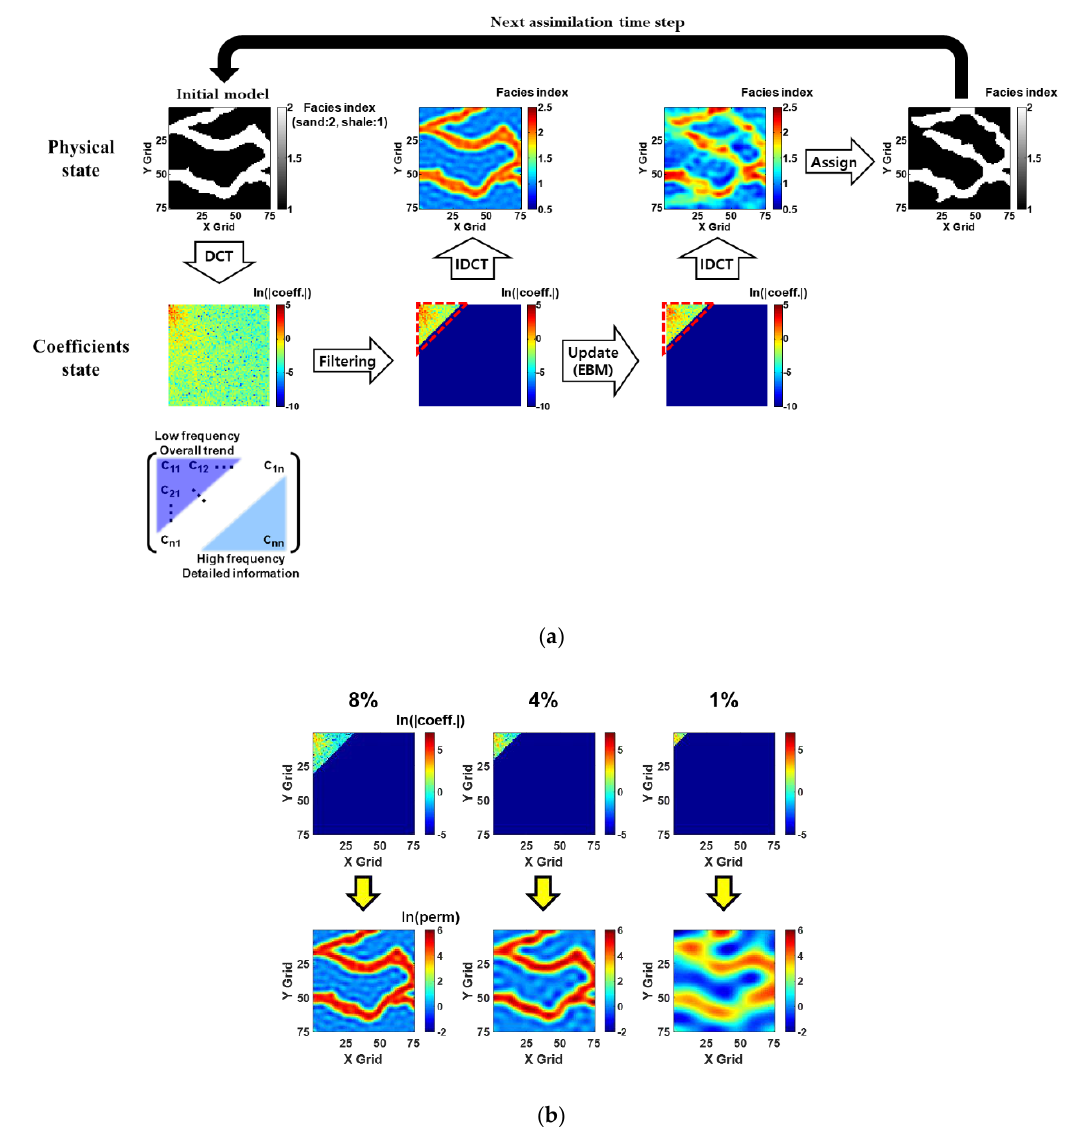
Figure 1. ( a ) One realization example of the discrete cosine transform (DCT) principle and application to history matching procedure and ( b ) sensitivity analysis of the DCT coefficients.